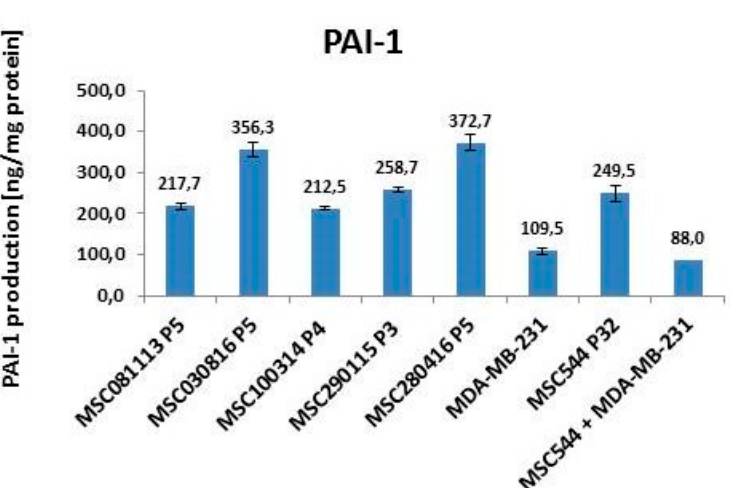
Figure 4. Quantification of PAI-1 in different MSC cultures and MDA-MB-231 breast cancer cells. The intracellular levels of PAI-1 were quantified in five different primary MSC cultures at different passages and compared with MSC544 P32. Moreover, the amount of PAI-1 in MSC544 was compared to MDA-MB-231 breast cancer cells and to a 3D spheroid that formed after long-term co-culture (62 d) between MSC544 GFP and MDA-MB-231 cherry . Data represent the mean + s.d. ( n = 4). In contrast, PAI-1 expression in MDA-MB-231 cells was much lower, reaching only 109.5 ng/mg protein (Figure 4). Previous work in the non-metastatic MCF-7 breast cancer cell line demonstrated